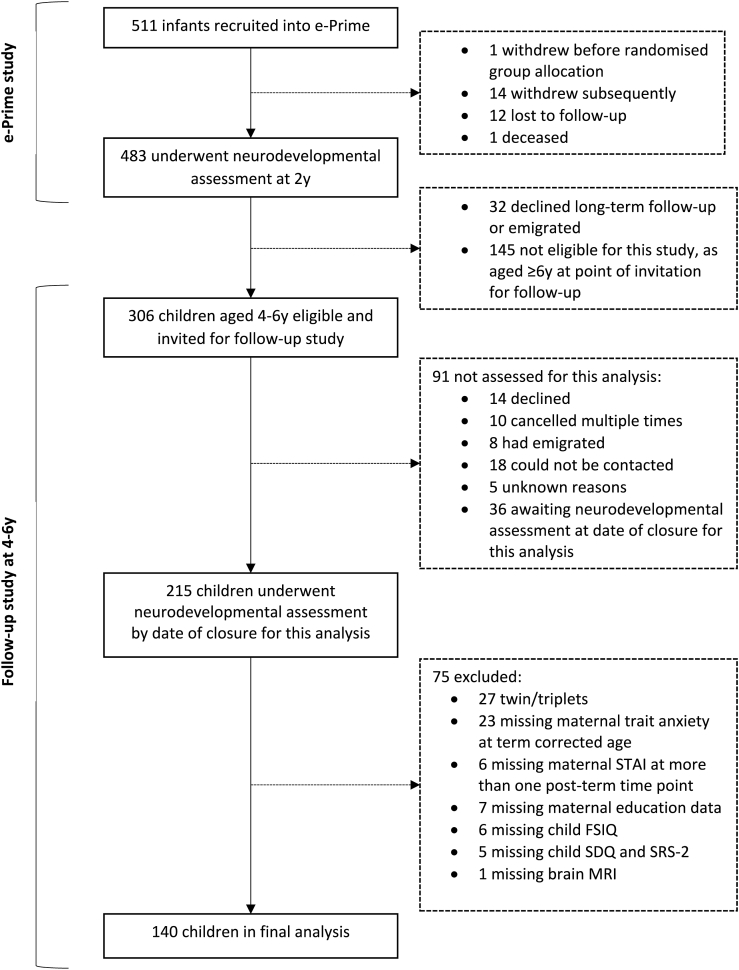
Recruitment flow chart.